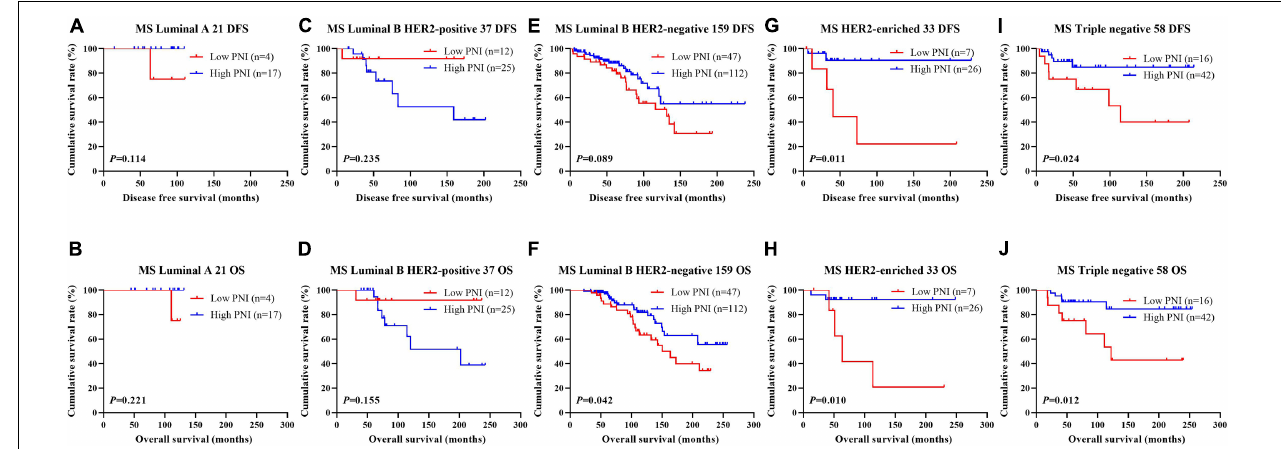
FIGURE 5 | Disease-free survival (DFS) and overall survival (OS) for the prognostic nutritional index (PNI) of patients with breast cancer in different molecular subtypes in the non-neoadjuvant chemotherapy (NACT) group. (A,B) Kaplan-Meier analysis of DFS (A) and OS (B) for the PNI of patients with luminal A breast cancer in non-NACT group. (C,D) Kaplan-Meier analysis of DFS (C) and OS (D) for the PNI of patients with luminal B HER2-positive breast cancer in non-NACT group. (E,F) Kaplan-Meier analysis of DFS (E) and OS (F) for the PNI of patients with luminal B HER2-negative breast cancer in non-NACT group. (G,H) Kaplan-Meier analysis of DFS (G) and OS (H) for the PNI of patients with HER2-enriched breast cancer in non-NACT group. (I,J) Kaplan-Meier analysis of DFS (I) and OS (J) for the PNI of patients with triple-negative breast cancer in non-NACT group.